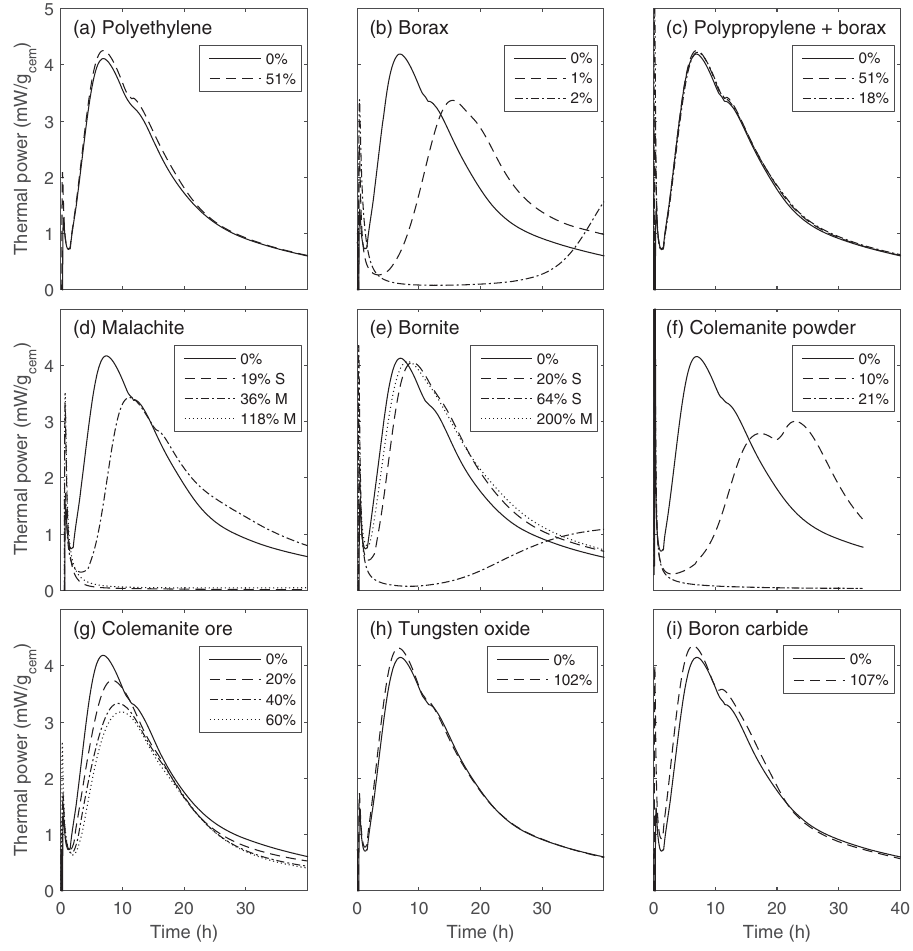
FIG. 3. Results from tests with isothermal calorimetry of compatibility between hydrating cement and different materials used for radiation shielding. The samples and the used concentrations are given in Table I and the results are described in Table